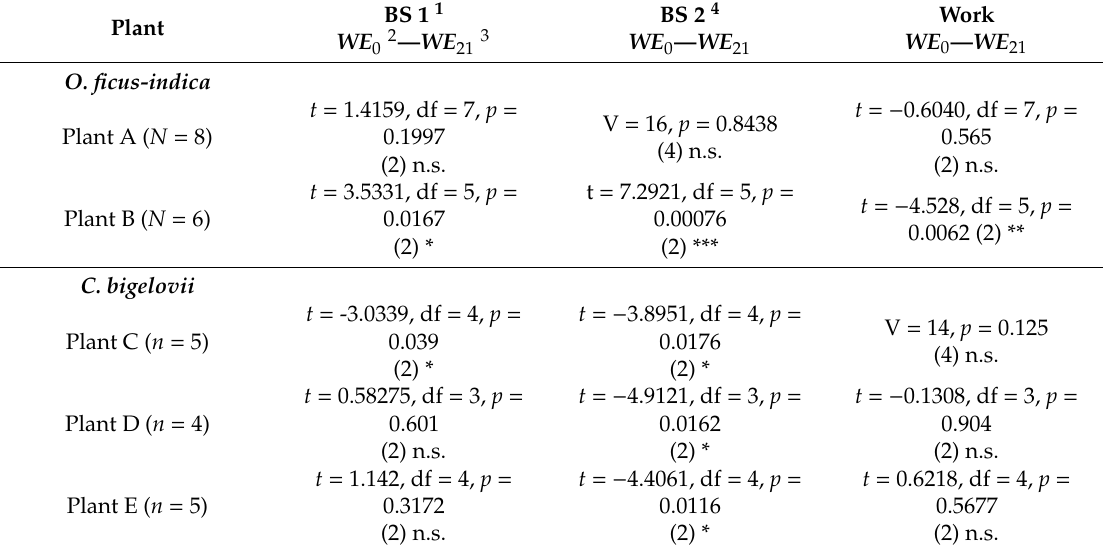
Table A2. Statistics of mechanical parameters comparing wounding e ff ects at two di ff erent stages of the two plant species O. ficus-indica and C. bigelovii